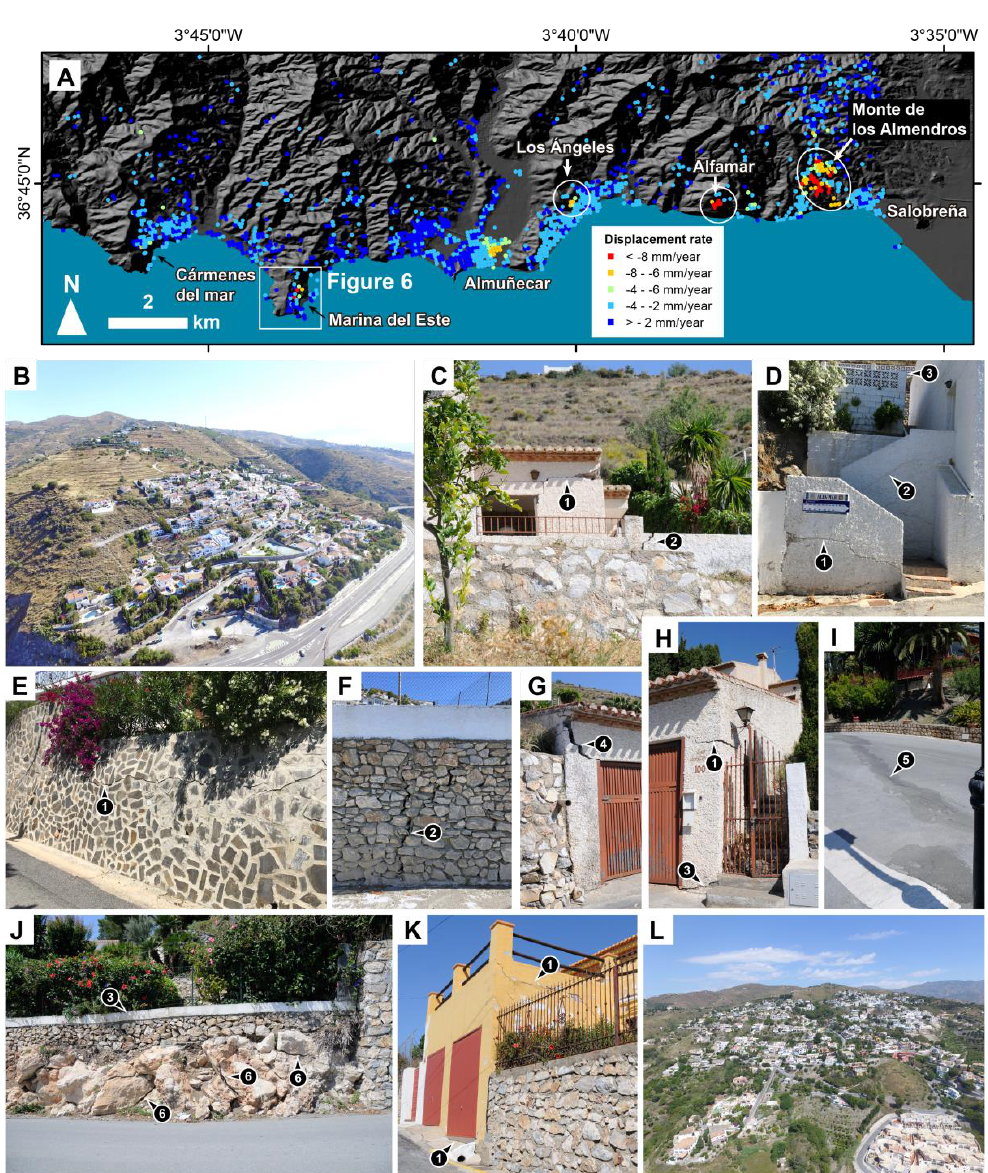
Figure 8. ( A ) GEP map data of the coast of the Granada province between the Los Cármenes del Mar resort and Salobreña. The urban states with ground instability problems are pointed out; ( B ) Aerial view of the Alfamar resort; ( C – K ) Types of damages observed in the Alfamar and Monte de los Almendros urban states. (1) Horizontal cracks on the top of buildings due to deflections of the slabs due to differential settlements; (2) Diagonal cracks and fissures due to foundation settlements; (3) Deformed walls; (4) Cracks due to deformation of the structure junctions; (5) Curved crack in the asphalt with a small step indicating differential settlement; (6) Open cracks in the bedrock; and, ( L ) Aerial view of the Monte de los Almendros resort.